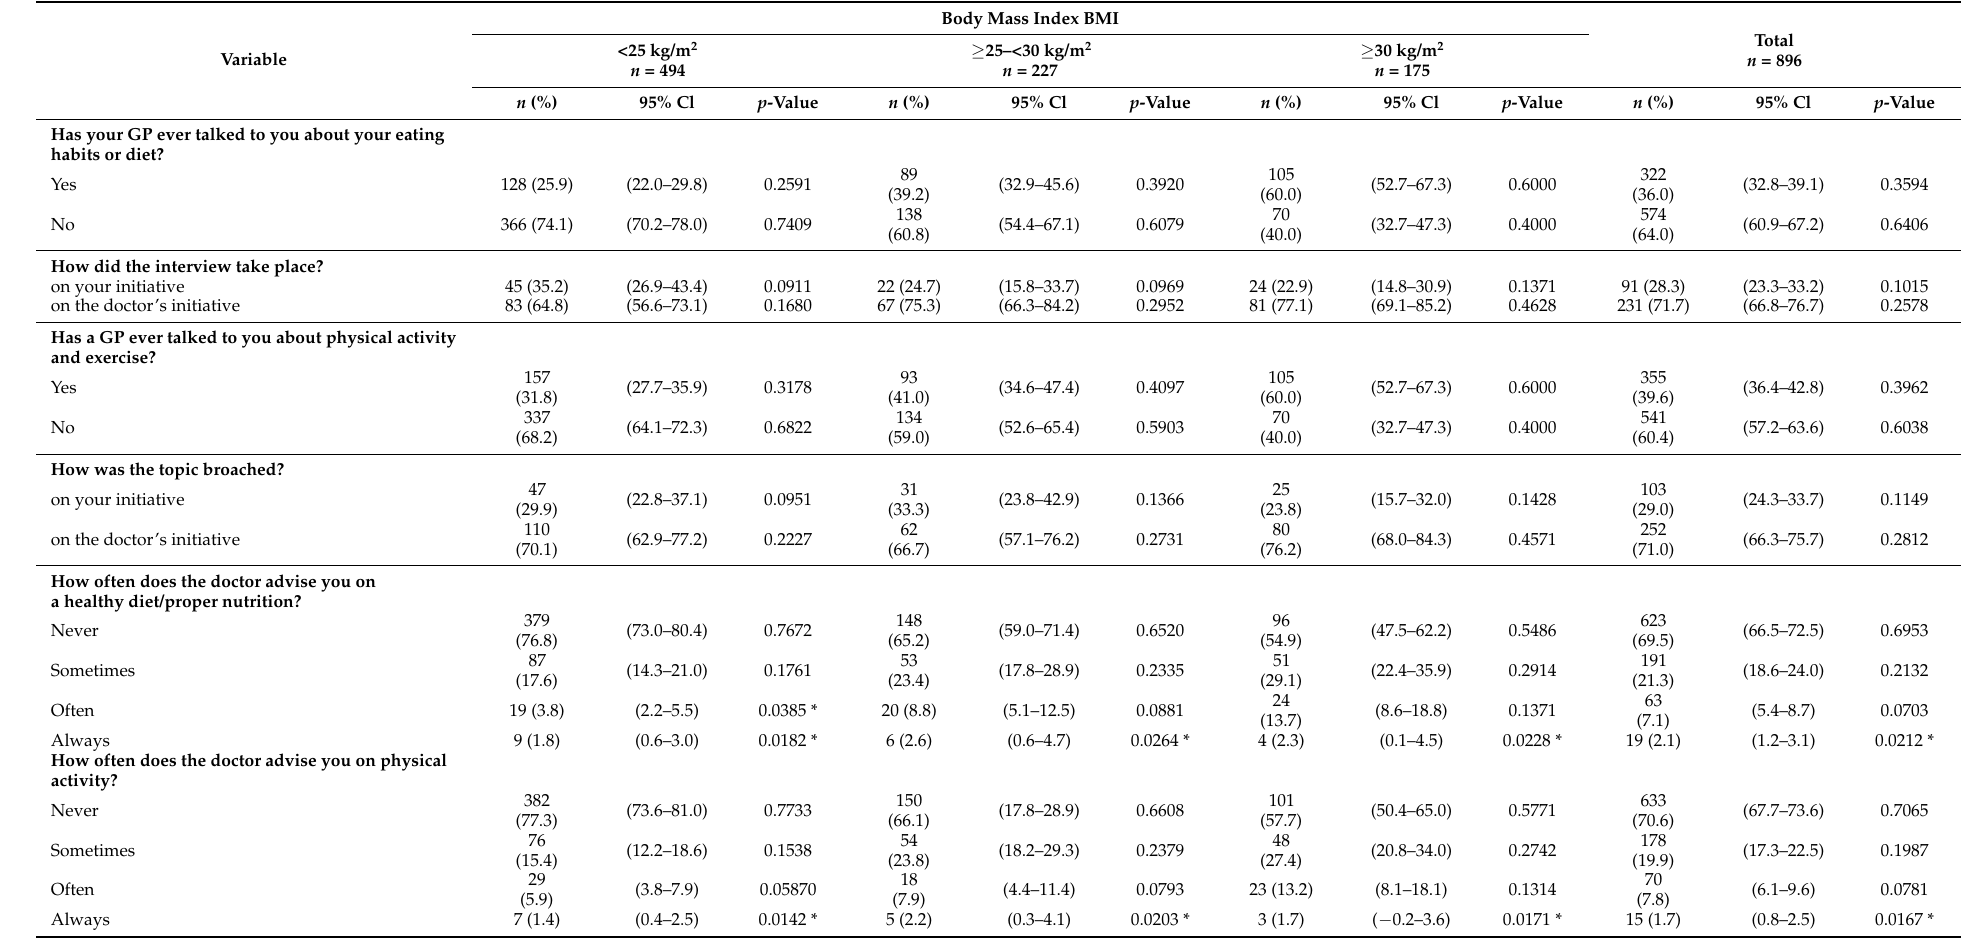
Table 2. Percentage of primary care patients whose GP advised changing eating habits and physical